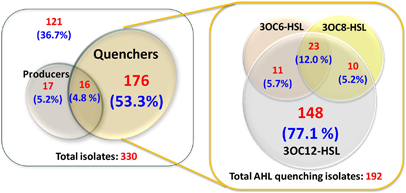
Distribution of isolates according to their capacity to produce and/or quench N-acyl homoserine lactones (AHLs). A total of 330 isolates, including 307 and 23 strains of bacterial and fungal origins, respectively, were cultured from the floccular sludge community during the bioreactor operation from weeks 40–44. All isolates were screened for AHL production by different bioassays and LC-MS/MS, as well as for their capability to quench 5 μM of AHLs with short (3OC6-HSL), medium (3OC8-HSL) and long (3OC12-HSL) acyl chains after 2 h incubation. Residual AHLs were quantified using the A. tumefaciens A136 agar-based spot bioassay.